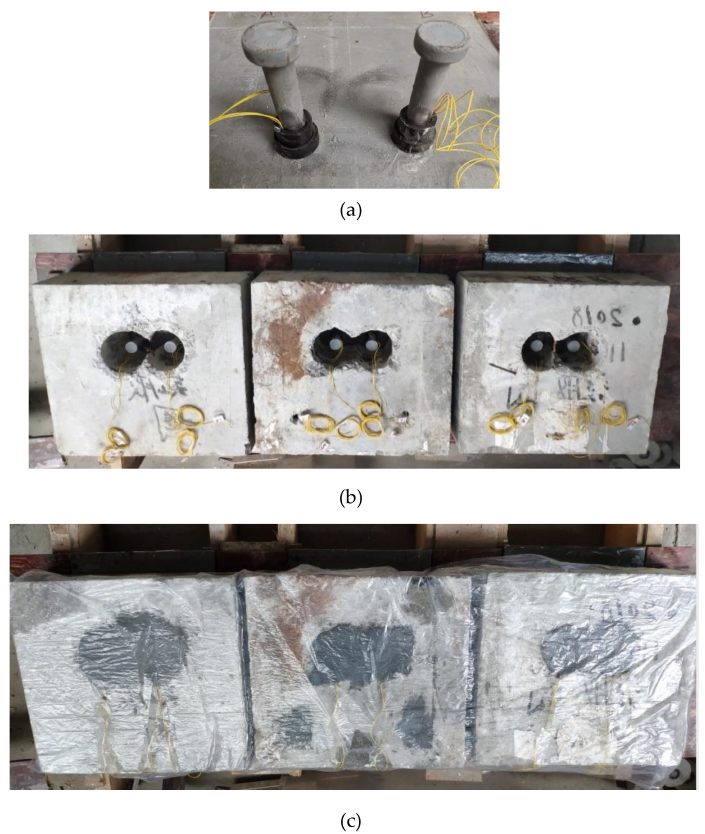
Figure 9. Photos for specimen fabrication: ( a ) strain gauge and rubber sleeve installation; ( b ) placing the precast concrete slab; ( c ) UHPC